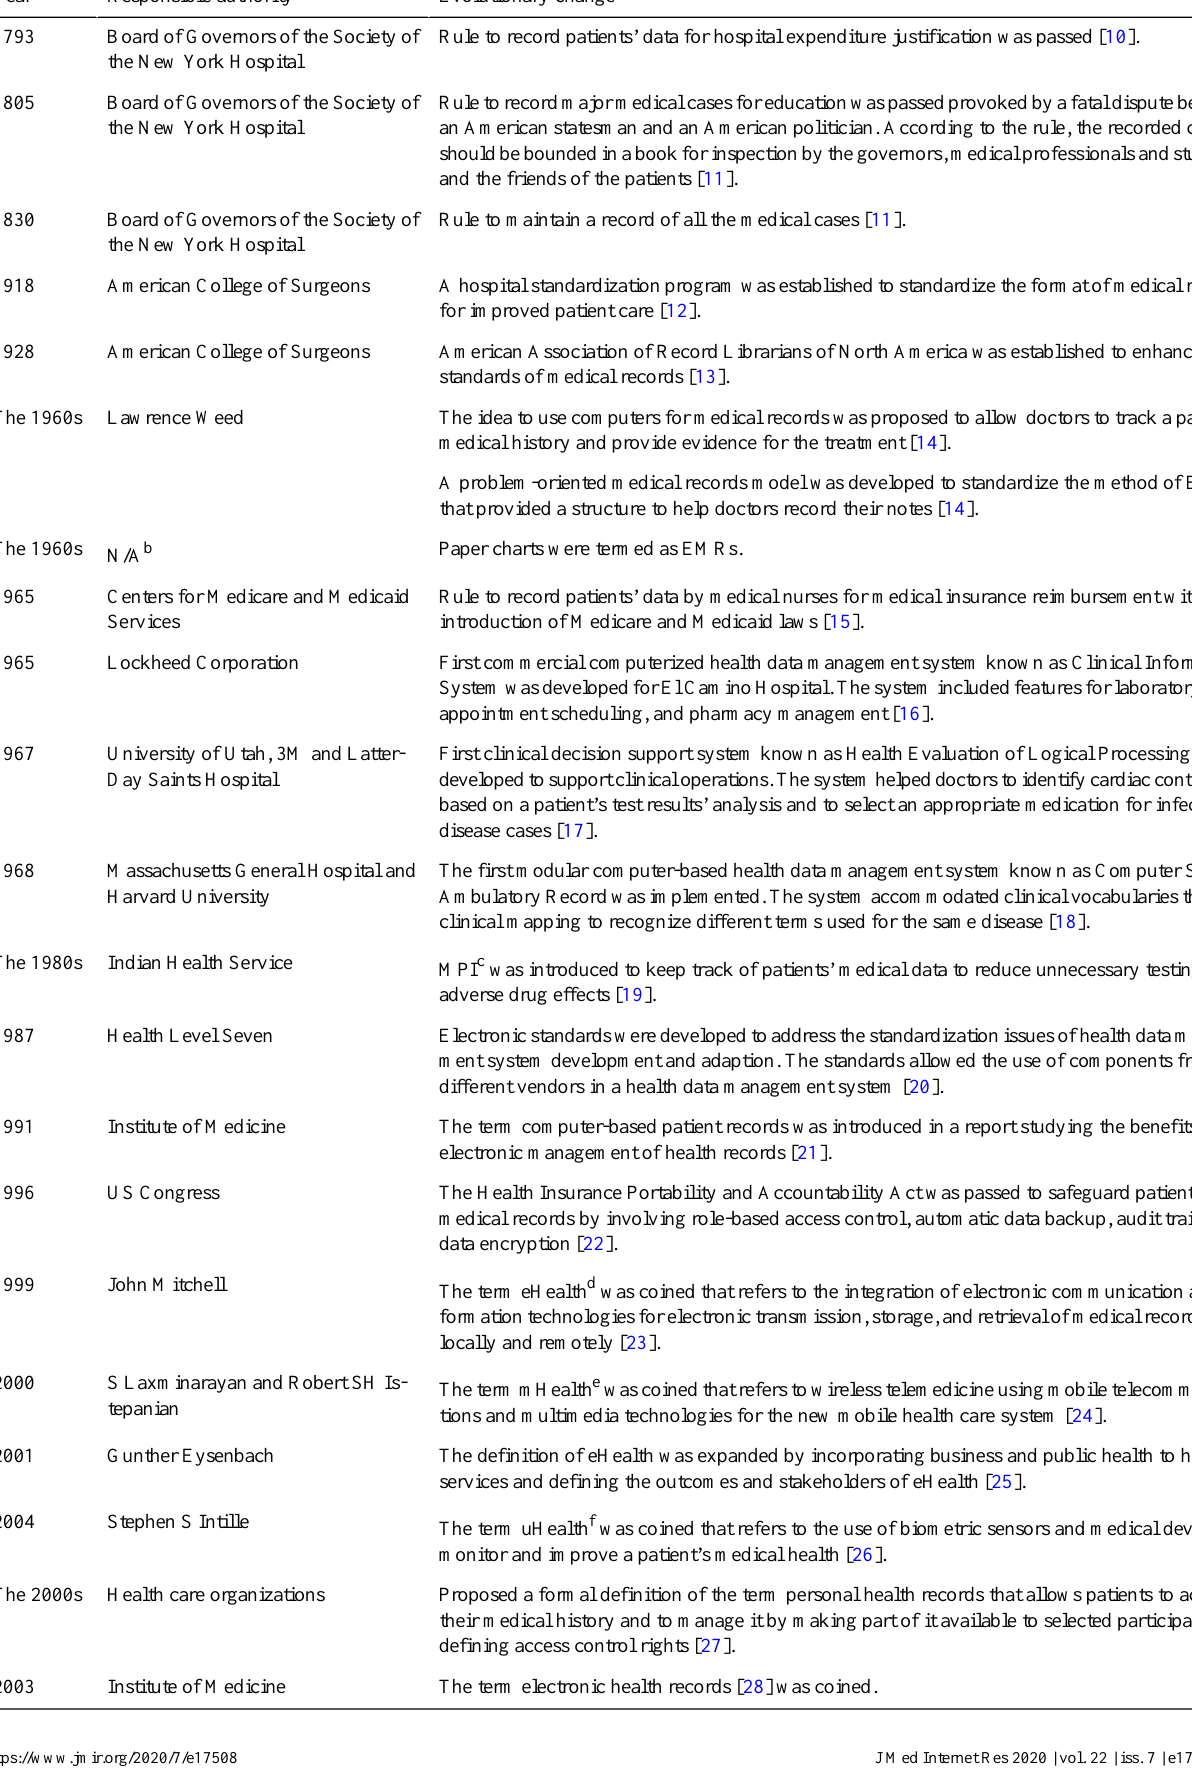
Table 1. Events that have triggered the evolution of health data management systems.